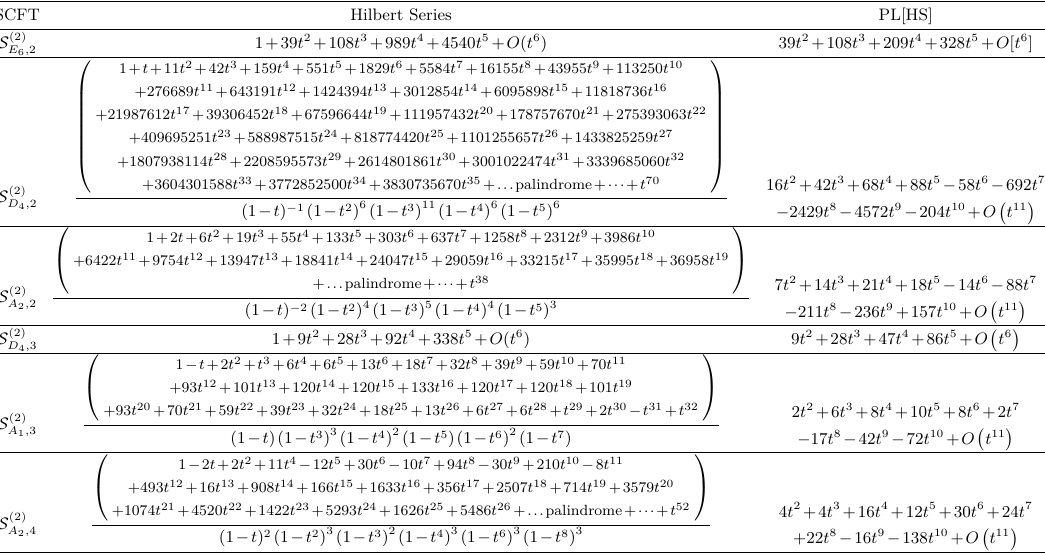
Table 3. Coulomb branch Hilbert series and plethystic logarithm for the magnetic quivers of S ( r =2) theories in table 1. The unrefined monopole formula can be evaluated exactly for all but two cases. The unrefined PL confirms the dimension of the global symmetry.